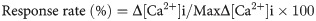
The agonistic activity of evocalcet on hCaR-expressing HEK293 (hCaR-HEK293) cells.The transient changes in the cytoplasmic calcium concentration (Δ[Ca2+]i) induced by receptor activation were measured. (A) The effect of evocalcet on the Δ[Ca2+]i value in hCaR-HEK293 cells. (B) The effect of evocalcet on the response rates elicited by increasing the extracellular calcium level in hCaR-HEK293 cells. The response rate was calculated using the following formula:
Responserate(%)=Δ[Ca2+]i/MaxΔ[Ca2+]i×100
Δ[Ca2+]i: Subtraction of basal [Ca2+]i from maximum [Ca2+]i observed after addition of evocalcet; Max Δ[Ca2+]i: Δ[Ca2+]i at the maximum Ca concentration (3 mmol/L).